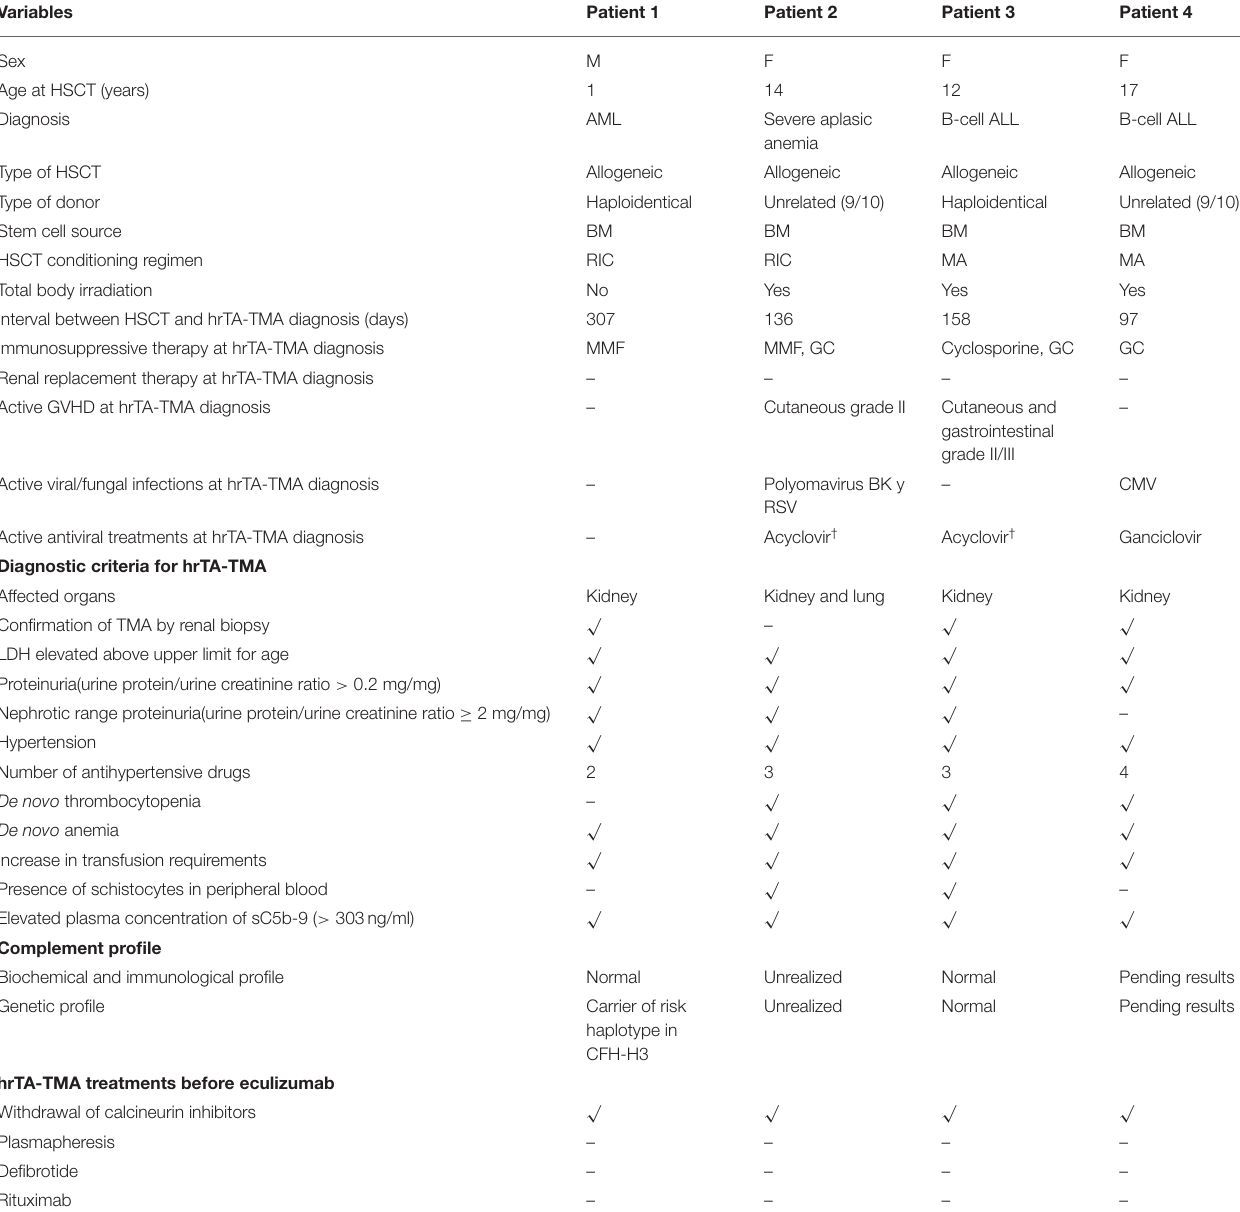
TABLE 2 | Demographic and disease